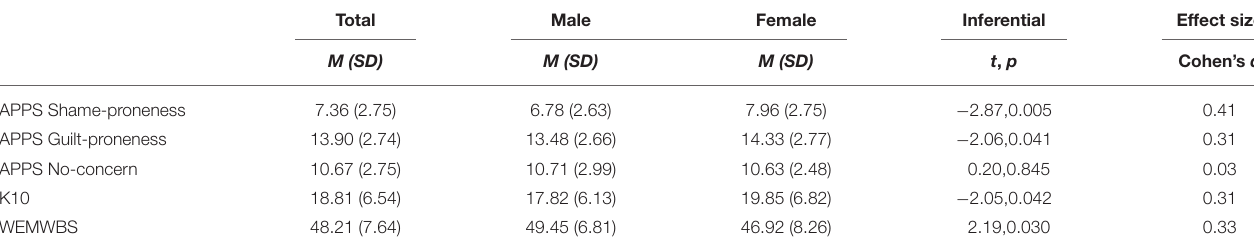
TABLE 3 | APPS means and SDs by sex.